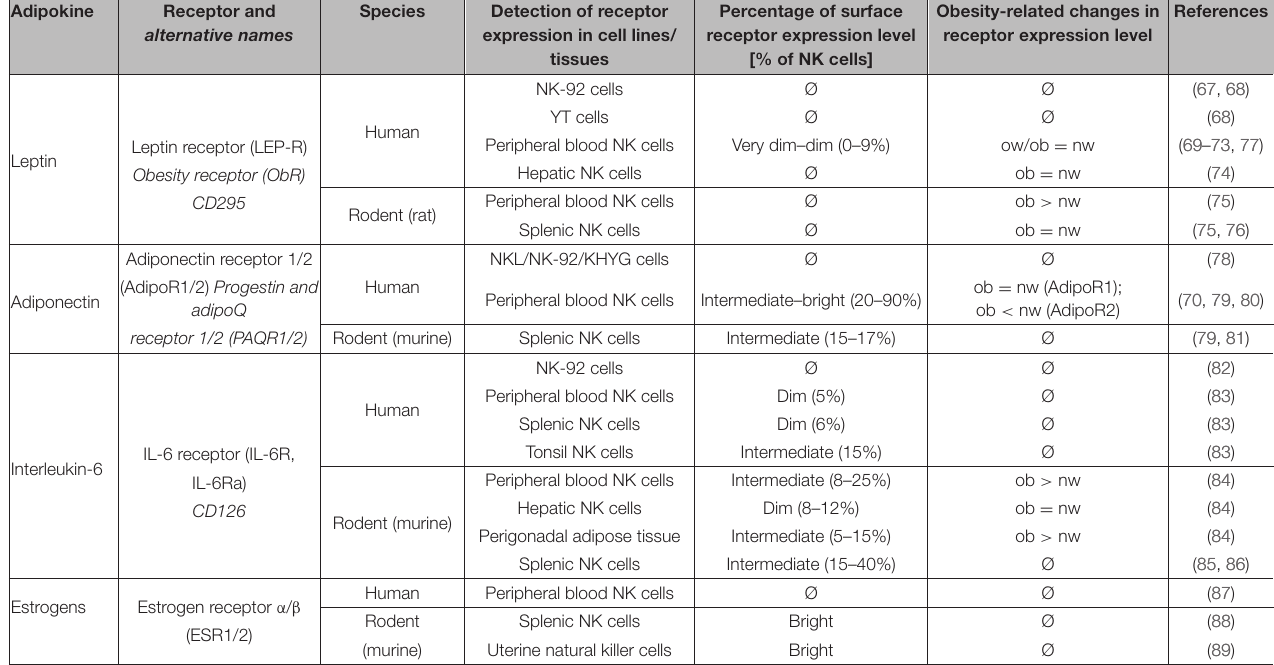
TABLE 1 | Expression of adipokine receptors on human and rodent NK